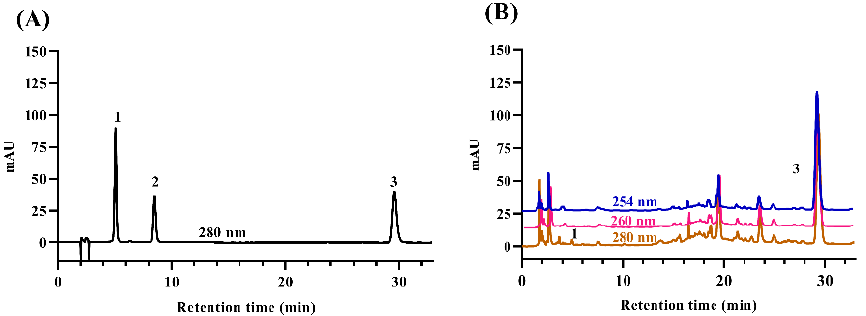
Figure 1. HPLC chromatograms of standard sample at 280 ( A ) and olive leaves at 254, 260 and 280 nm ( B ). 1. Oleuropein; 2. Hydroxytyrosol; 3. Tyrosol.